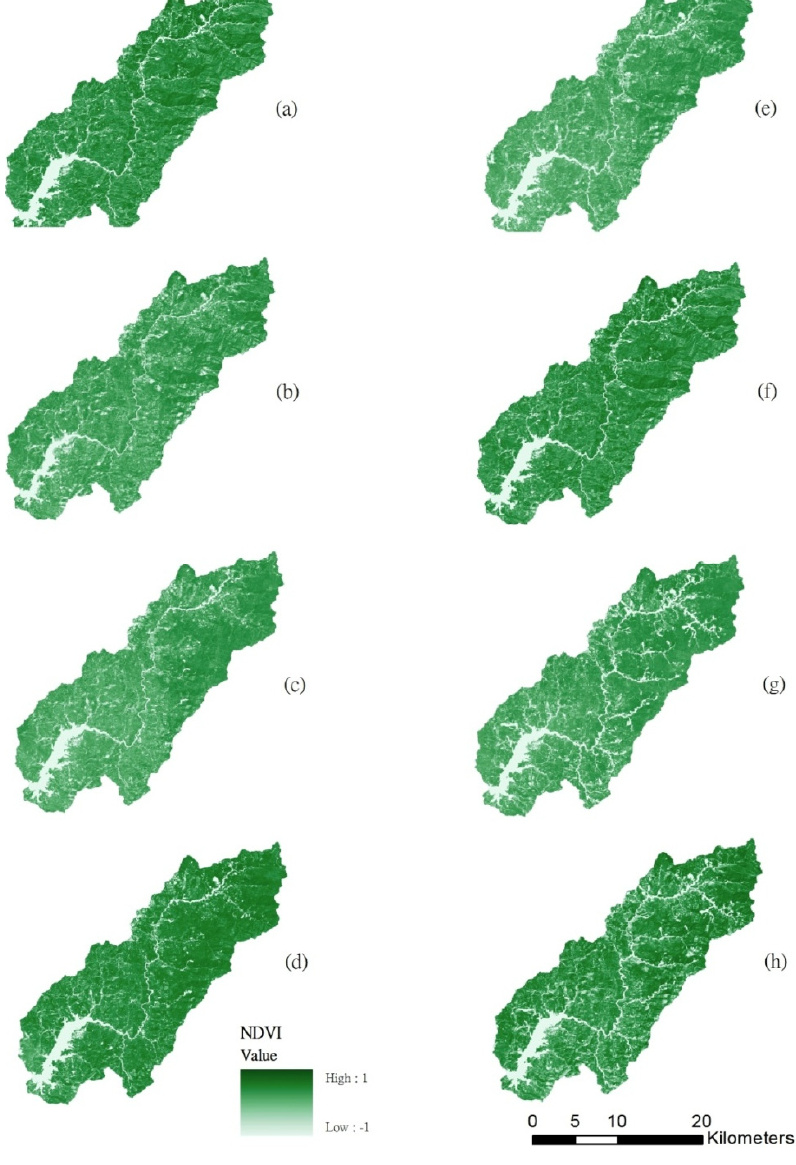
Figure 5. Boxplot of NDVI values for ( a ) 1, ( b ) 2, and ( c ) 3 km buffer